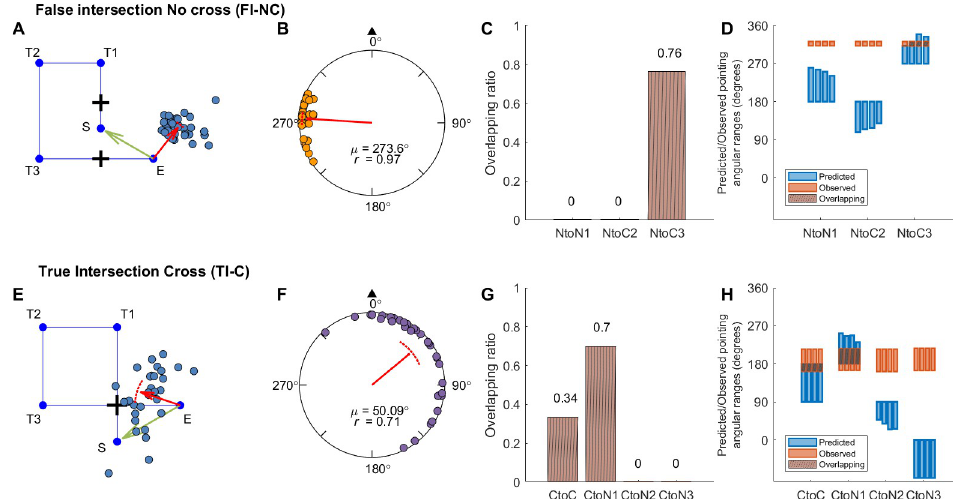
Fig 8. Response pointing directions and hypothesis comparison results in Experiment 2 (FI-NC and TI-C conditions). Panel A, E: Example pointing locations in one path (A: Path 8; E: Path 4). The red arrow indicates the circular mean direction and the distance of the pointing across all participants. Panel B, F: Mean pointing error (AE G ) across paths for each condition. Panel C, G: Mean overlapping ratio between observed and predicted pointing ranges across paths for each hypothesis (Fig 7, S2 Table). Panel D, H: Predicted or observed pointing angular ranges (in degrees) for individual paths. Abbreviations and legend are the same as in Fig 3.